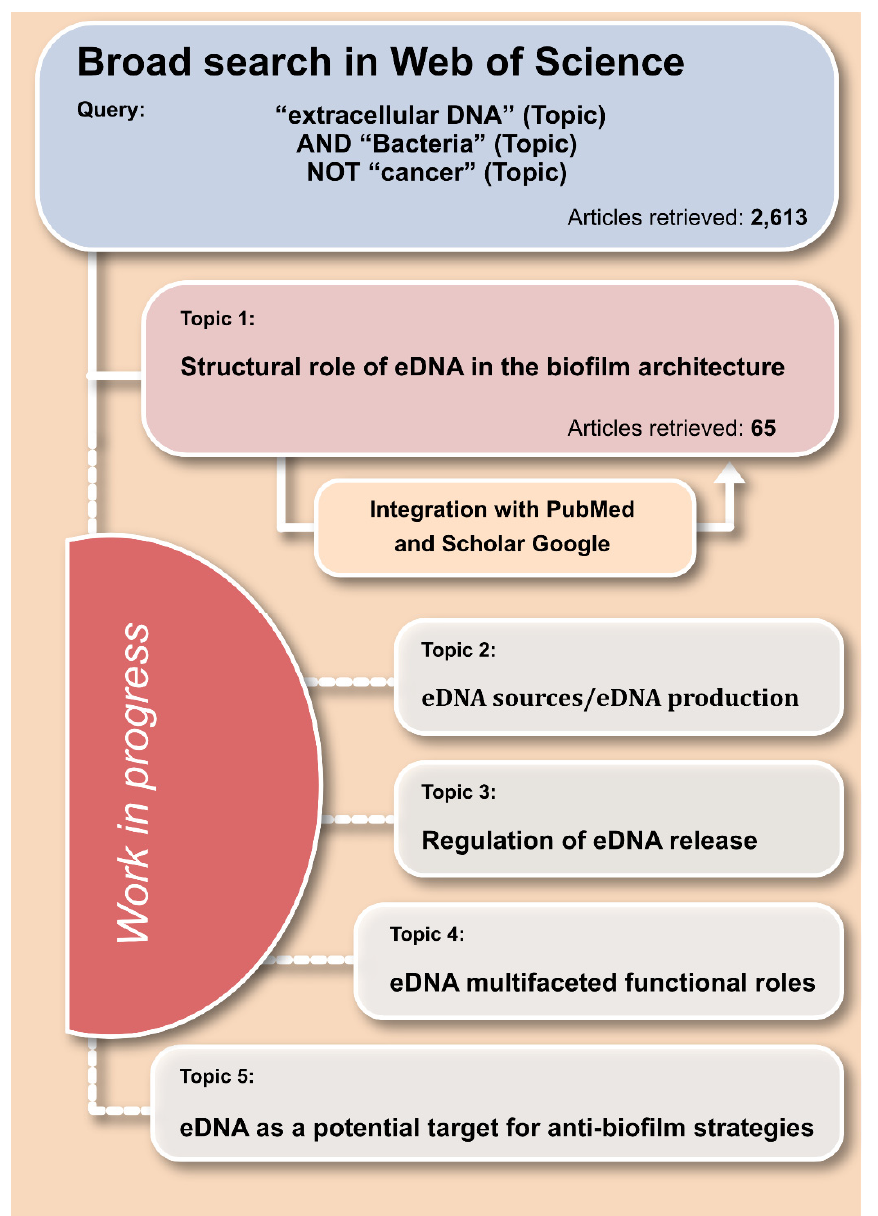
Figure 1. Scheme of the systematic review .